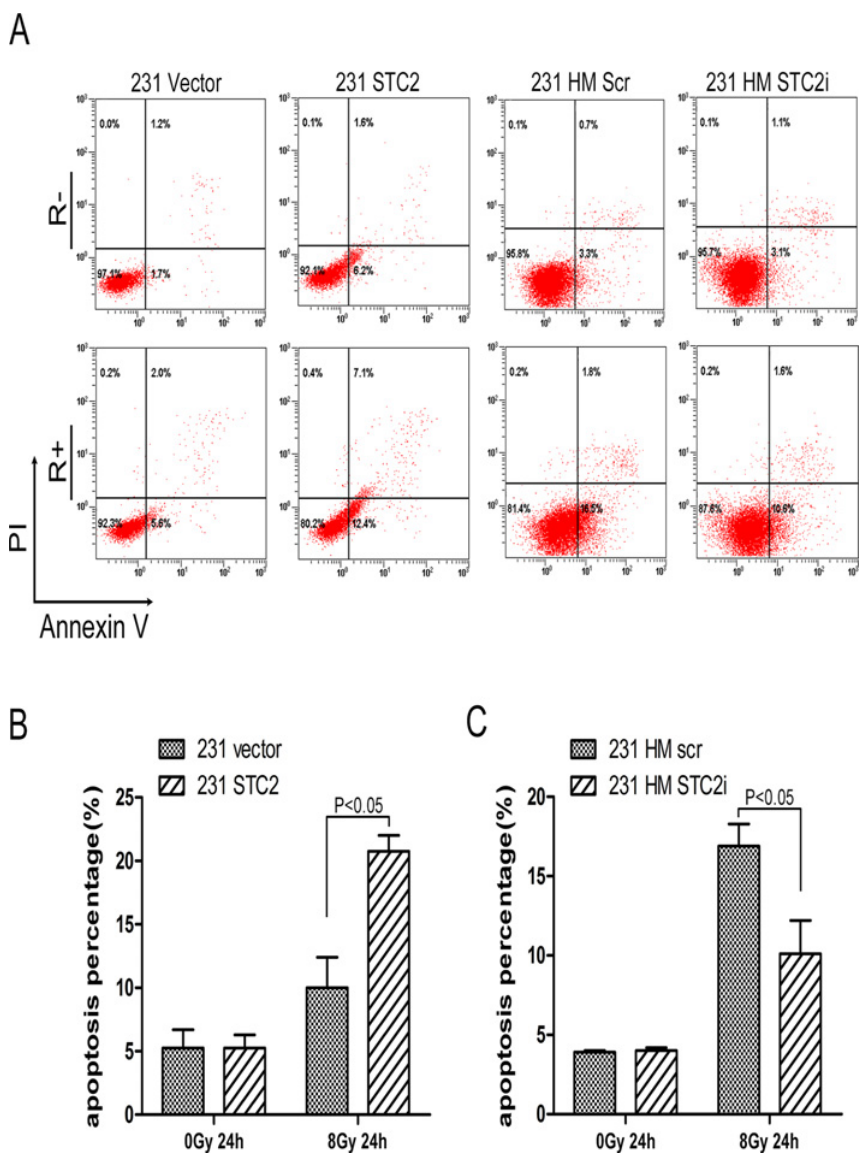
Fig 4. STC2 promotes cell apoptosis. Cells were treated with a dose of 8Gy X-rays, apoptosis was then measured by flow cytometry in 231 STC2 cells or 231 HM STC2i cells and their corresponding control cells. A-B , Representative images of apoptosis assay. C , The percentage of apoptotic cells (P < 0.05). Error bars = 95% CIs. R+: with Radiation Treatment, R-: without Radiation